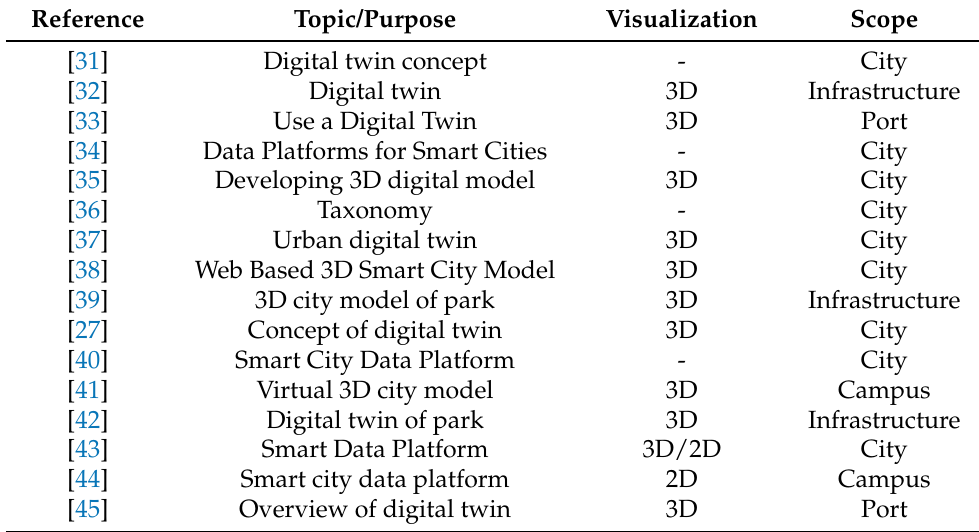
Table 1. Comparison of similar